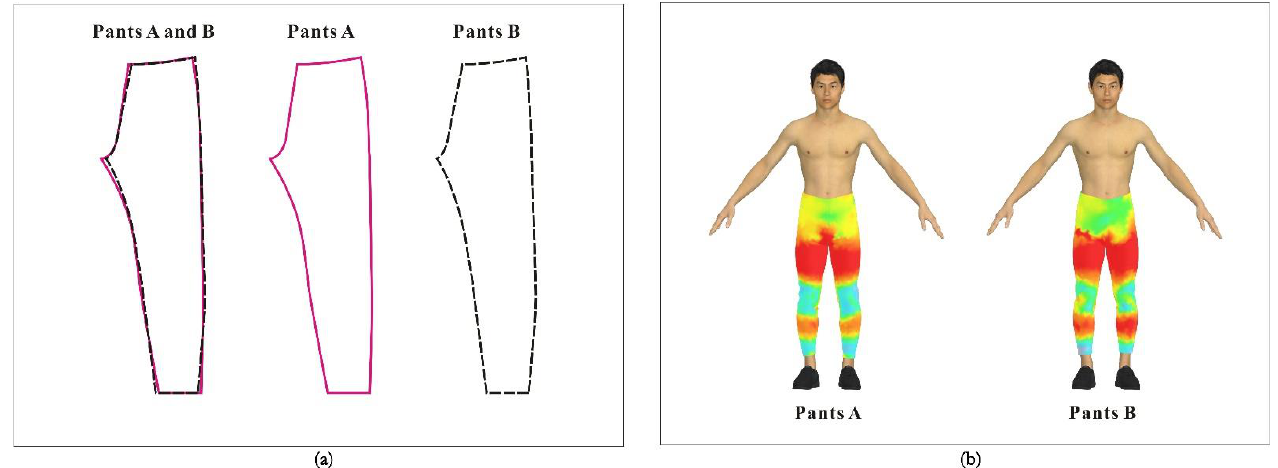
Figure 12. Comparison of the pants patterns and fitting effects. ( a ): pants patterns comparison; ( b ): pants fitting effects